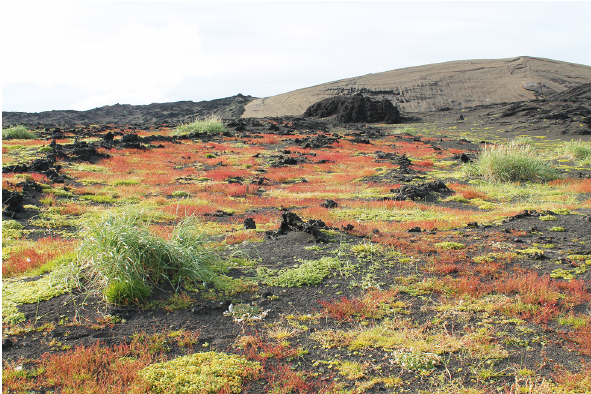
Fig. 3. Surtsey tephra slopes with scattered flowering plants (Photo: BM 2013).